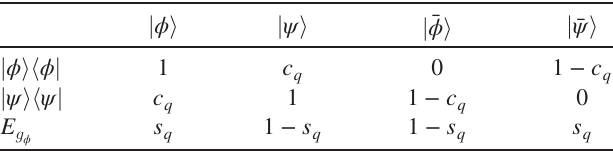
TABLE I. Data table in the ideal quantum